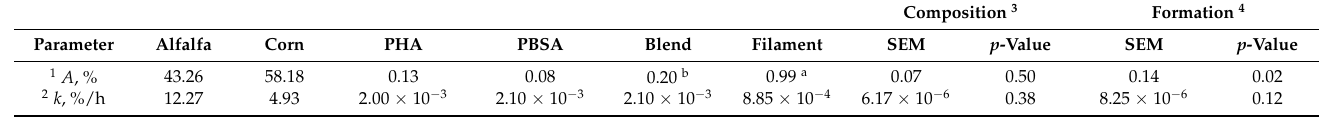
Table 1. Ruminal disappearance kinetics parameters of alfalfa hay and corn silage forage controls and PHA, PBSA, Blend, and Filament.